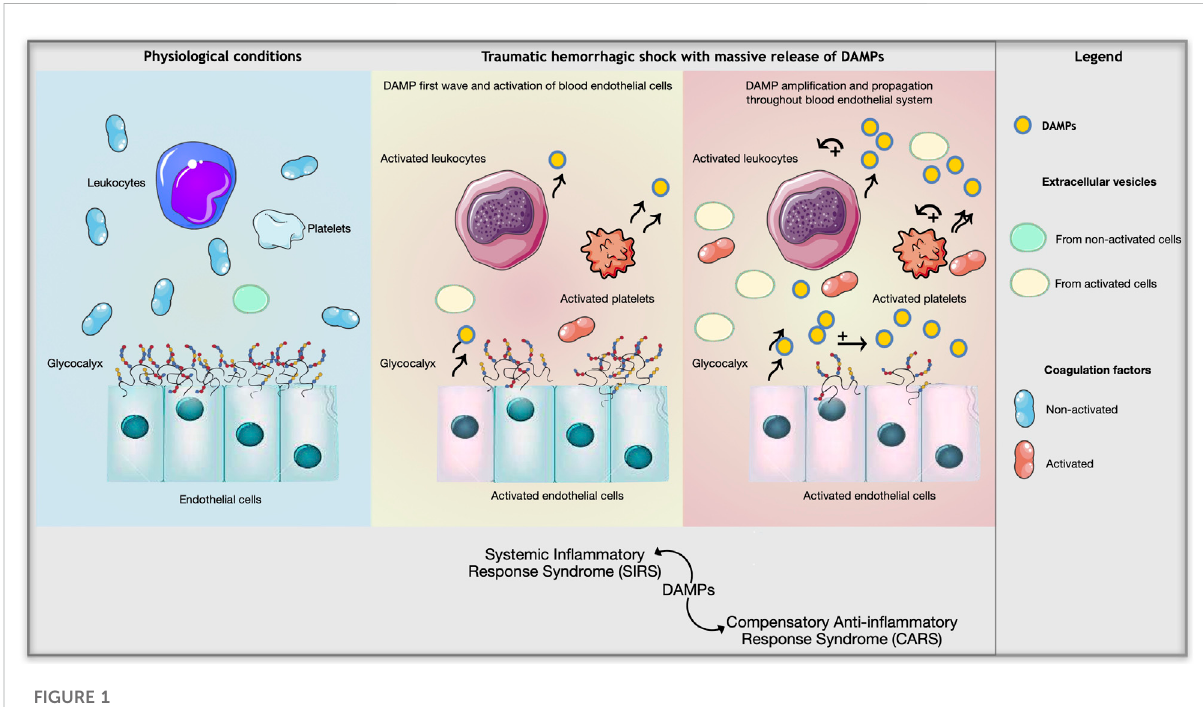
FIGURE 1 Impact of massive release of DAMPs on the blood endothelial system during traumatic hemorrhagic